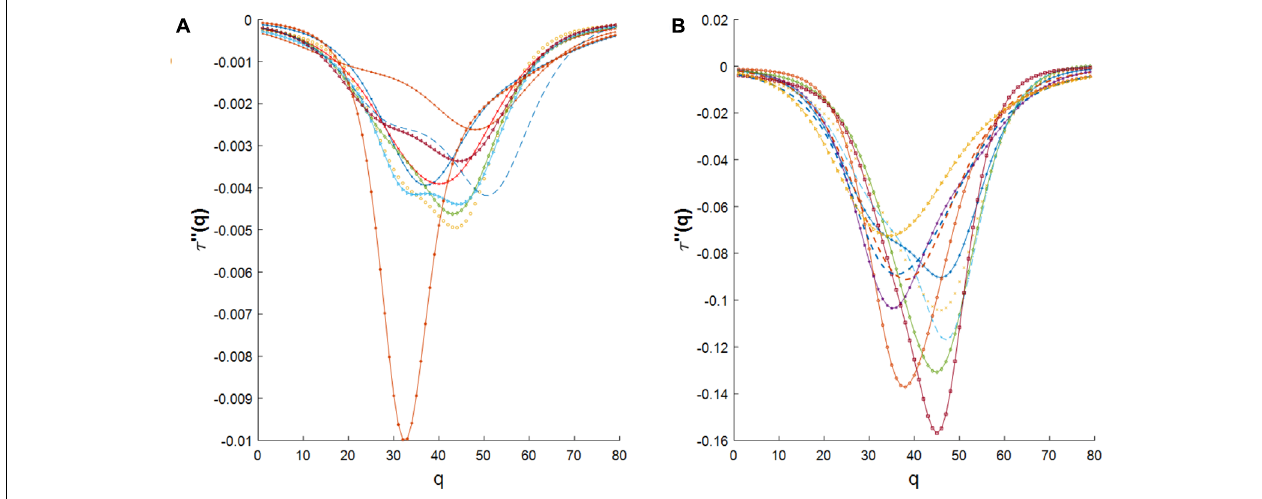
FIGURE 6 | (A) The second derivative of the mass exponent for cross-dependencies in E. coli. (B) The second derivative of the mass exponent for cross-dependencies in S. cerevisiae